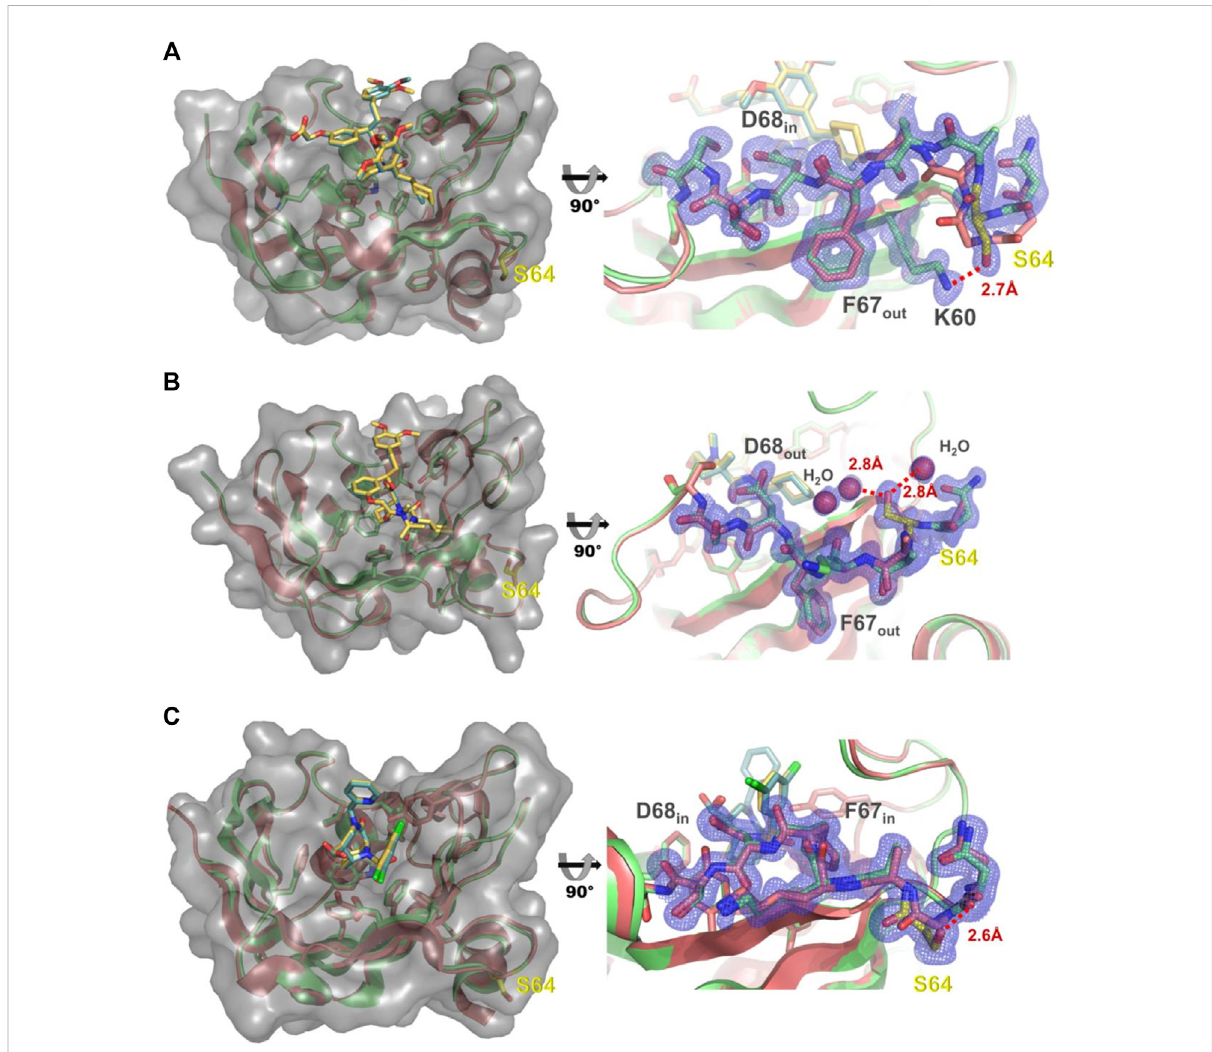
FIGURE 6 (A) Left:Structure ofFKBP51-G64S (greencartoon,PDB:7R0L)bound to SAFit1 (golden sticks) superposedwiththeFKBP51:iFit1 complex (cyan cartoon, teal sticks, PDB: 4TW6). The surface of FKBP-G64S is indicated in lighter grey. Right: Detailed view of the glycine to serine substitution. The observed electron density contoured at1 σ for residues 60and 63 – 70isshown as bluemesh. The hydrogenbond between lysine 60 and serine 64is depictedasredline. (B) Left:StructureofFKBP51-G64S (greencartoon,PDB:8BA6)boundtomacrocyclic ligand( 5 )(goldensticks)superposed with the FKBP51 bound to the same ligand (cyan cartoon, teal sticks, PDB: 7AWF). The surface of FKBP-G64S is indicated in lighter grey. Right: Detailed view of the glycine to serine substitution. The observed electron density contoured at 1 σ for residues 63 – 69 is shown as blue mesh. The hydrogen bonds between serine 64 and two water molecules are depicted as red lines. (C) Left: Structure of FKBP51-G64S (green cartoon, PDB: 8BAJ) bound to FK [431] ligand ( 6 ) (golden sticks) superposed with the FKBP51 bound to the same ligand (cyan cartoon, teal sticks, PDB: 5OBK). The surface of FKBP-G64S is indicated inlighter grey. Right: Detailed view of the glycine to serine substitution.The observed electron density contoured at 1 σ for residues 63 – 69 is shown as blue mesh. The hydrogen bond between asparagine 63 and serine 64 is depicted as red